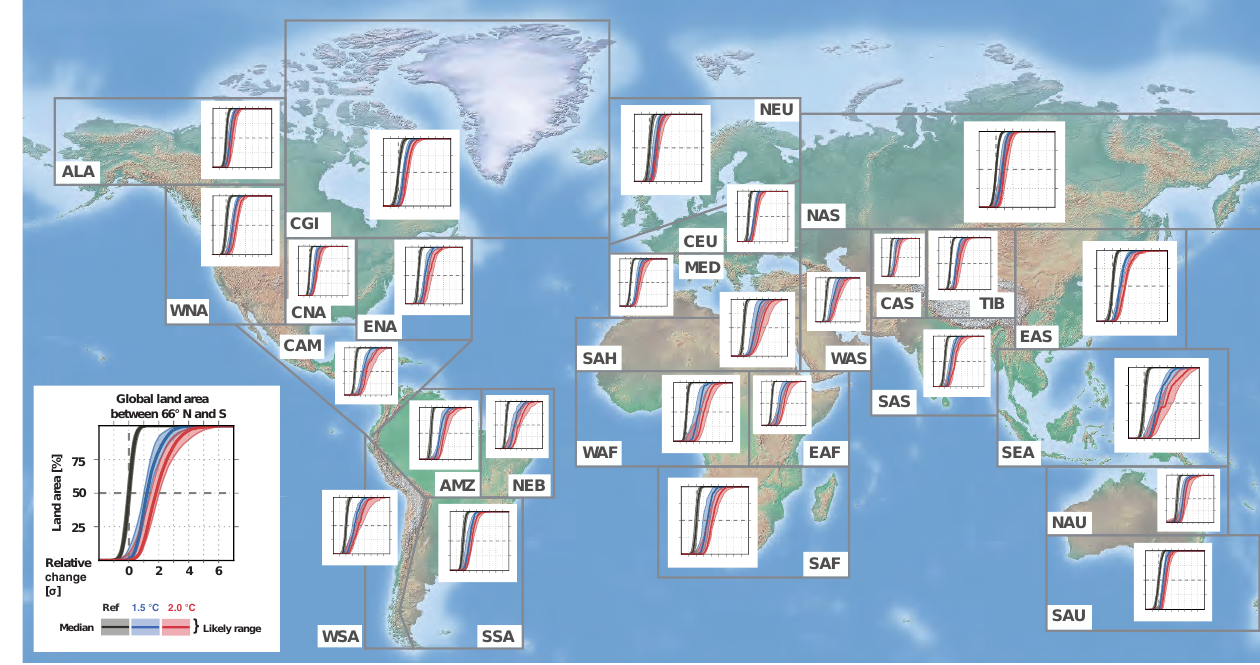
Figure 2. CDFs for projected regional aggregated changes in TXx (relative to the standard variation over the reference period) for the global land area between 66 ◦ N and 66 ◦ S (lower left corner) as well as resolved for 26 world regions separately (see Sect. 2 for further details). The graph axes are the same for all panels. Changes are given relative to the standard deviation over the 1986–2005 reference period. Note that a change in 2 (3)SD (standard deviations) implies that events with a reference return time of several decades (centuries) become the new normal, whereas a new normal of 4 σ refers to an event that would be extremely unlikely to occur in a reference period climate. Region impact overviews are provided in the